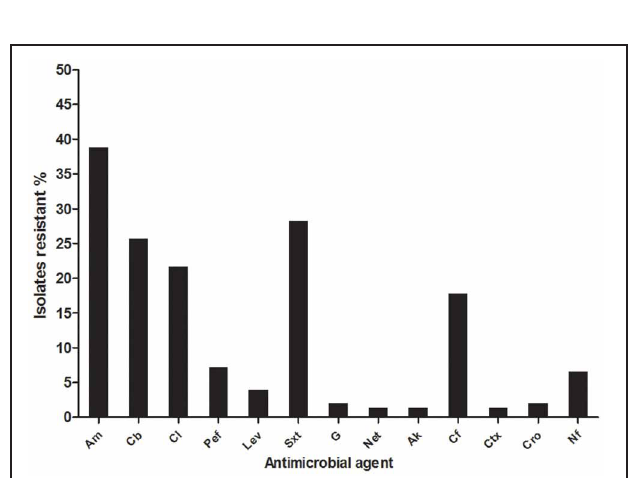
FIGURE 3 | Box and whiskers plot of results of microbiological analyses of San Pedro River in thirty sample location. Bacterial counts values are shown in a log 10 scale, (A) mesophilic microorganisms (B) total and fecal coliforms. Permissible maximum